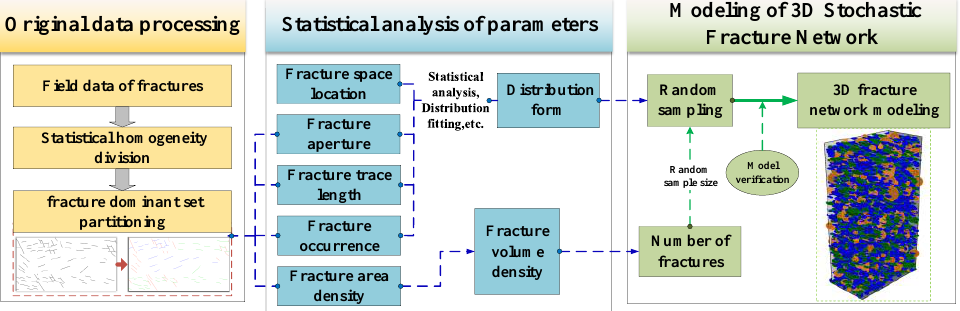
Figure 1. Modeling process of 3D fracture network .